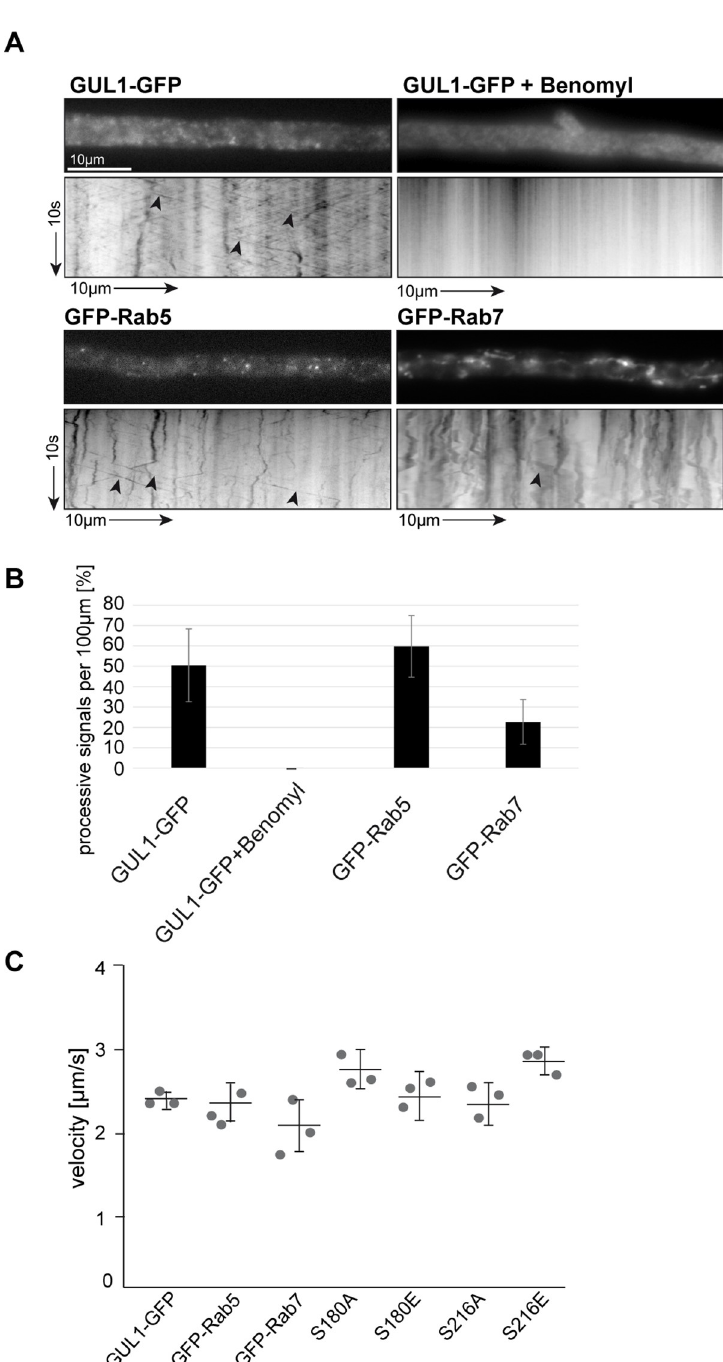
Fig 7. Shuttling of GUL1, Rab5 and Rab7. (A) Kymographs comparing hyphae expressing GUL1-GFP in the gul1 deletion strain, GFP-Rab5 and GFP-Rab7 in the wild type. Processive signals are marked by black arrowheads; arrow length on the left and bottom indicates time and distance, 10 s and 10 μ m, respectively; see also S2–S5 Movies). GUL1-GFP shuttling was inhibited by treatment with the microtubule inhibitor benomyl. (B) Amount of processive signals of GUL1-GFP, GUL1-GFP with benomyl, GFP-Rab5 and GFP-Rab7. Given are the processive signals (moving distance � 5 μ m) in percent per 100 μ m hyphal length (7 to 18 hyphae per strain in three independent experiments). Error bars indicate standard deviation (S3 data set). (C) The average velocity of fluorescent signals per kymograph is indicated for all strains. Data points represent three means out of seven to 21 independent hyphae. At least 10 signals/ hypha were analysed in all strains (S4